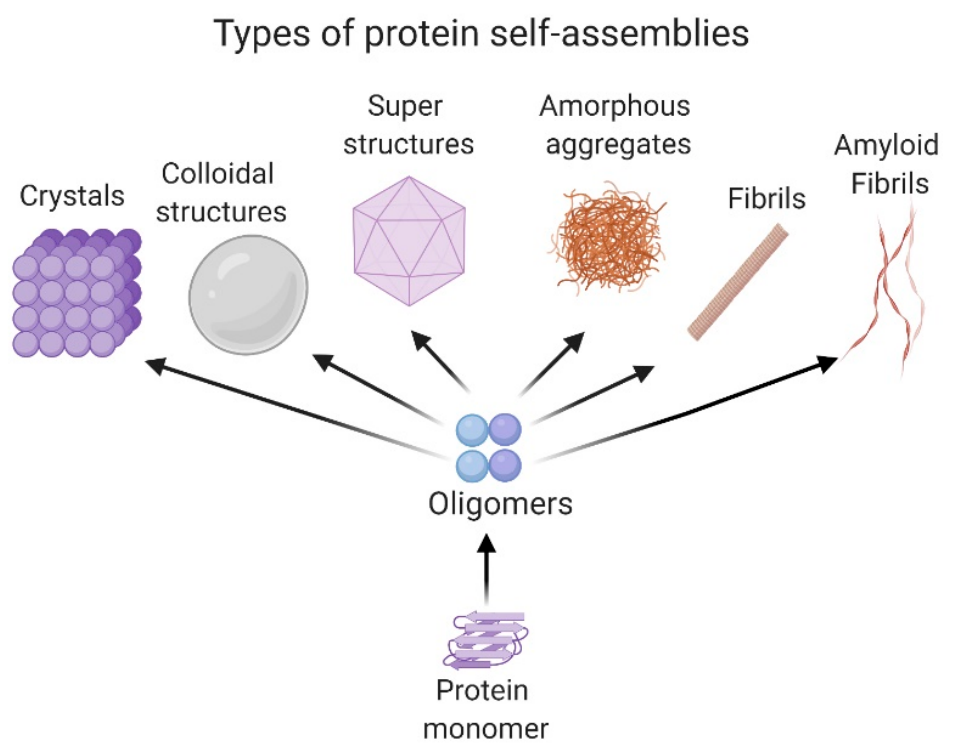
Figure 1. Schematic representation of the different types of the most observed protein self-assemblies. Image created with Biorender.com.